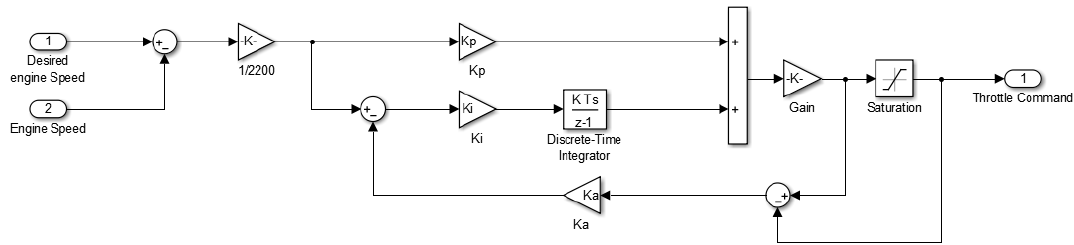
Figure 4. Feedback controller for engine speed control based on proportional–integral (PI)